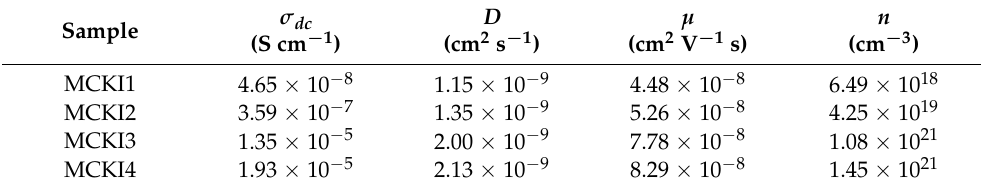
Table 2. Numerical values of σ dc , D , µ , and n at ambient